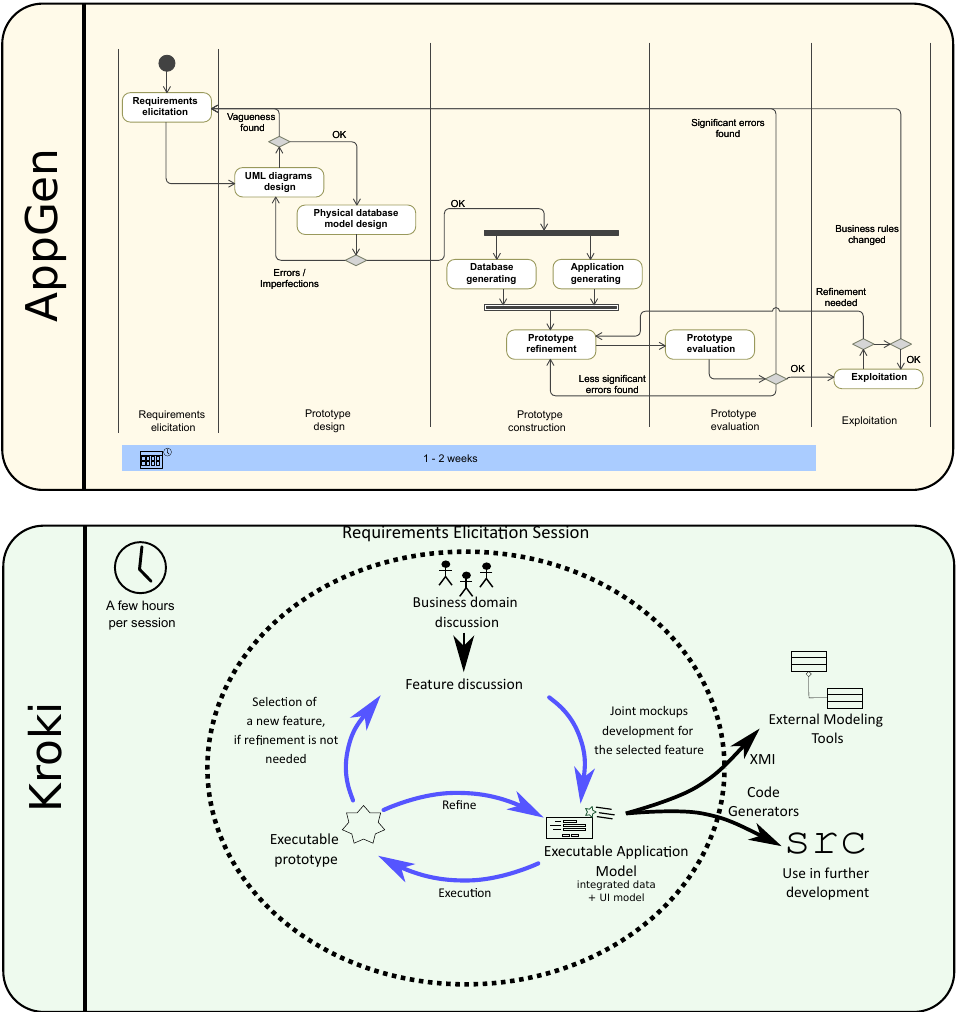
Figure 15. A comparison of development processes using the AppGen [19] and Kroki